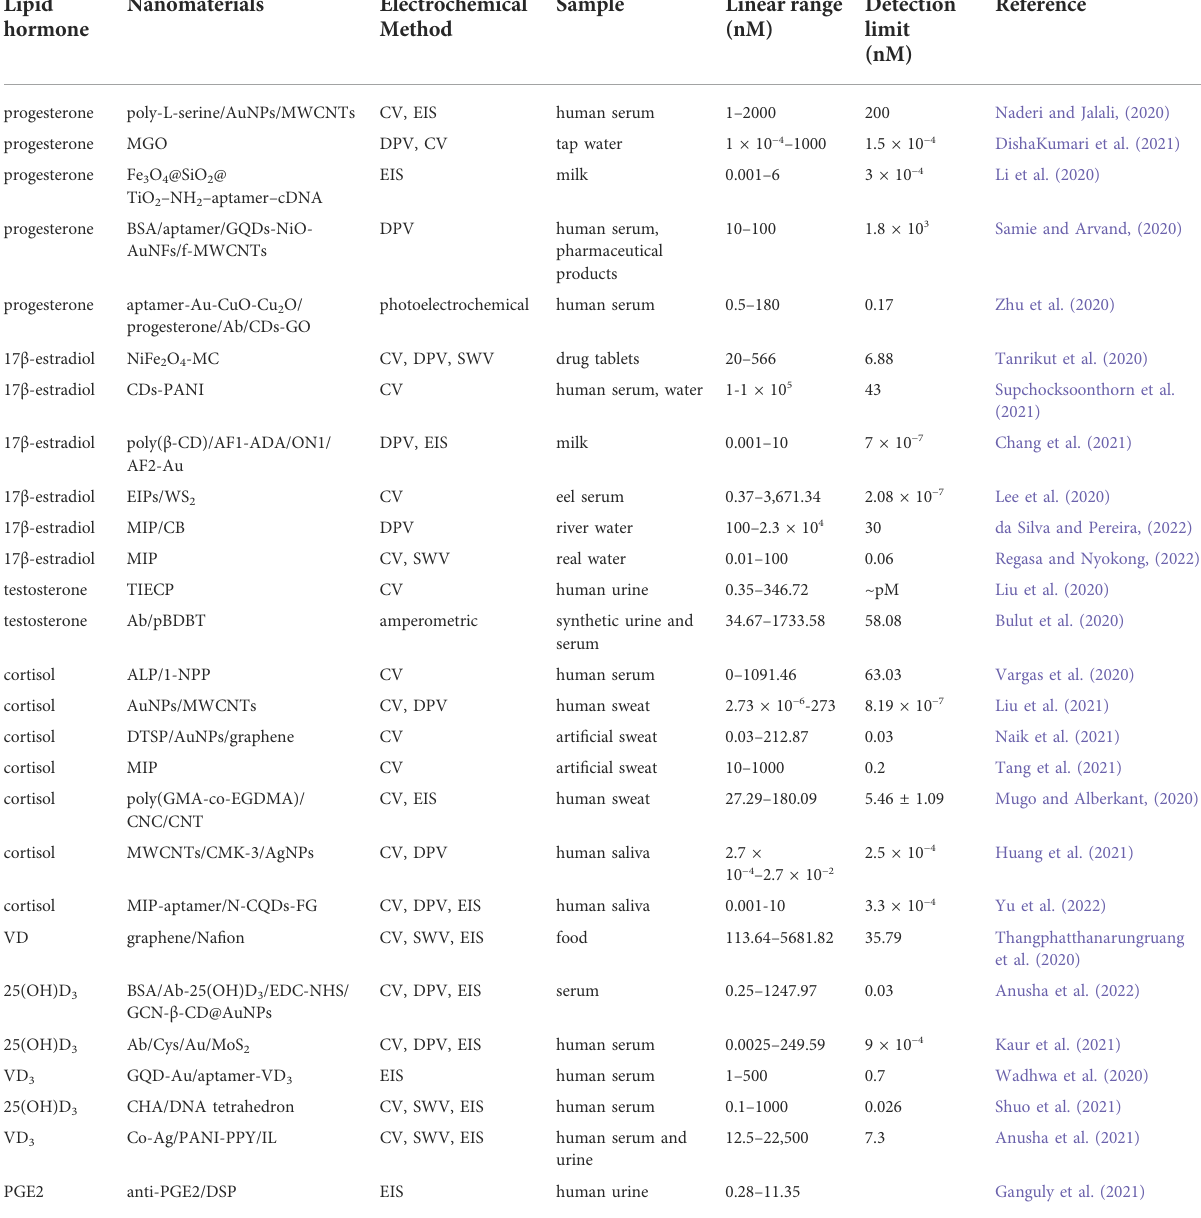
TABLE 1 A summary of electrochemical sensors for the detection of lipid hormone. Lipid